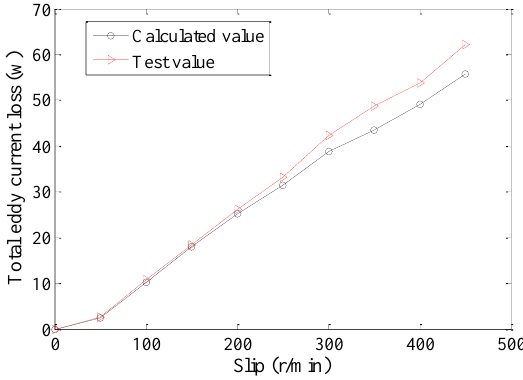
Figure 10. Comparison of calculated values and experimental results for total eddy current losses.